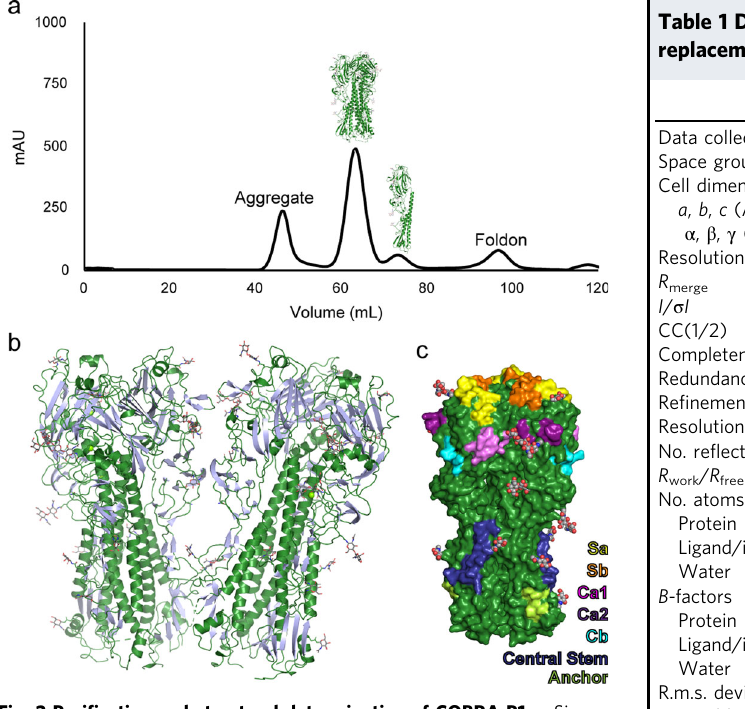
Fig. 2 Puri fi cation and structural determination of COBRA P1. a Size exclusion trace of COBRA P1 following thrombin digestion to release the T4 fi britin Foldon trimerization domain and af fi nity tags. Trimeric HA formed the major peak, with aggregate and monomeric HA forming minor species. b The asymmetric unit of the crystal structure consisting of two trimers, with β -strands colored silver and loops and helices in forest green. c Surface rendering of a single trimer. The major head antigenic sites are shown in yellow, orange, magenta, purple, and sky blue for Sa, Sb, Ca1, Ca2, and Cb, respectively. Residues comprising the Central Stem and Anchor epitopes are shown in royal blue and bright green. Carbon and oxygen atoms in glycans are colored as gray and red